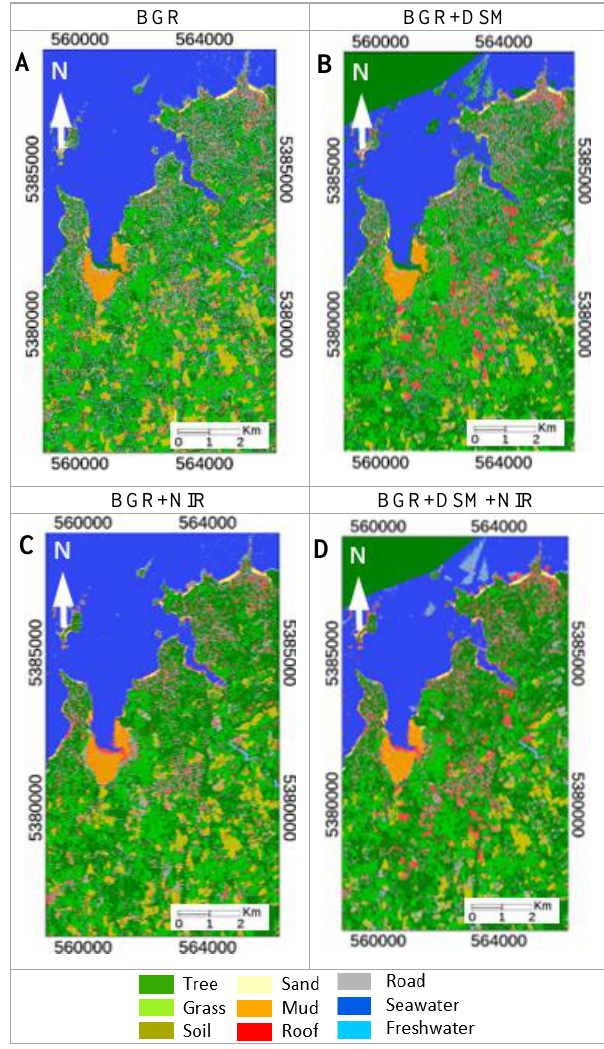
Figure 6. Maps of the land use/land cover classifications of the (A) Maximum Likelihood. Reference blue-green-red (BGR); (B) BGR + near-infrared (NIR); (C) BGR + digital surface model (DSM); (D) BGR + NIR + DSM Finally, the contribution of the full dataset (BGR+DSM+NIR) yielded in 8.91% and 8.40% of OA gains with ML (Figures 5 and 6D) and SVM (Figures 5 and 7D), respectively. The best classification combination consisted in the full dataset, followed by the BGR+NIR, then the BGR+DSM with the ML algorithm. Our findings reflect another study on the use of the complete Pleaides-1 dataset (panchromatic + multispectral) allowed to the best classification to be performed (Beguet et al., Figure 5. Barplot of the Pleiades-1 DSM and NIR contributions to the BGR classification performance (Overall Accuracy) built with the maximum Likelihood (ML) and Support Vector Machine (SVM) algorithms